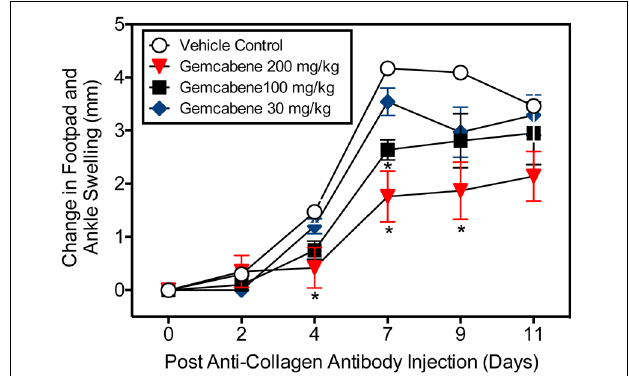
FIGURE 4 | Collagen antibody-induced joint swelling and arthritis in female BALB/c mice. Joint swelling and arthritis were induced in BALB/c mice by collagen antibody injection. Mice were dosed orally with vehicle (0.5% hydroxypropyl methylcellulose/0.25% Tween-80), or gemcabene at 30, 100, or 200 mg/kg in vehicle, 1 h prior to LPS injection, and then q.d. thereafter for the duration of the study. Change in footpad and ankle swelling was measured as described in the “Experimental Procedure” section. ∗ Indicates statistical significance ( p < 0.05). Data are expressed as Mean ±